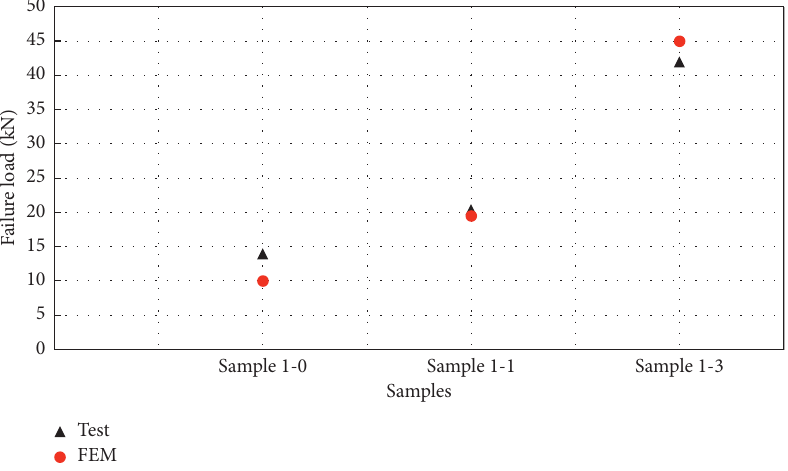
Figure 13: Comparison between the numerical simulation and laboratory test